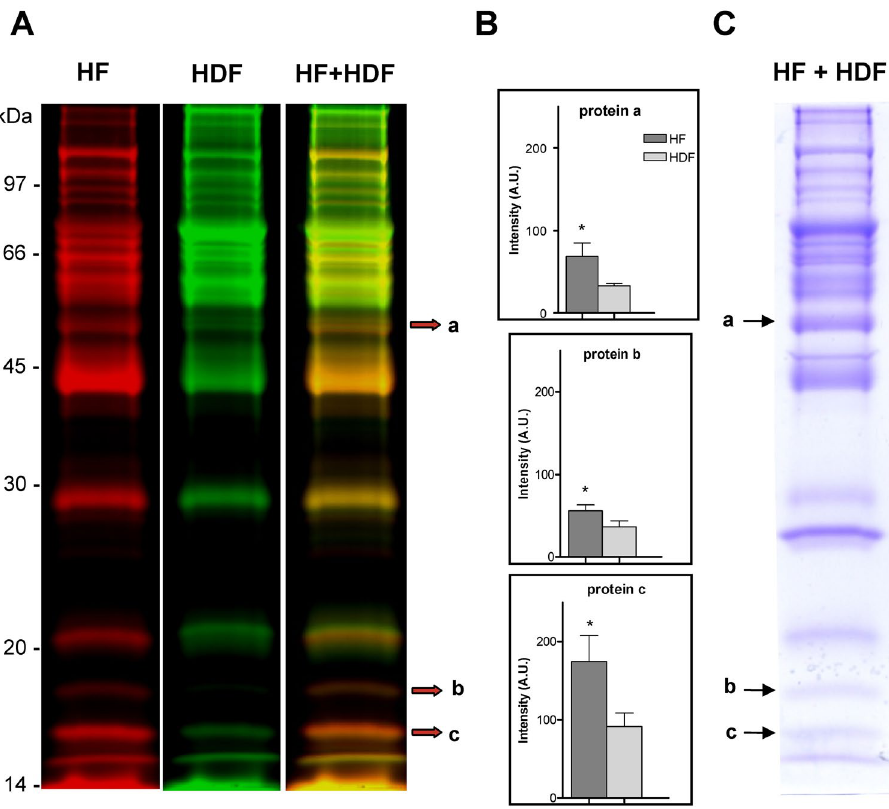
Figure 1. Differential protein detection of plasma samples of HF compared with HDF patients by fluorescence in gel electrophoresis (DIGE). ( A ) Albumin- and IgG-depleted plasma samples from high-flux haemodialysis (HF) and on-line haemodiafiltration (HDF) patients, were labelled with Cy5 or Cy3 fluorescent dyes. After labelling, the HF and HDF samples were combined and analysed by sodium dodecyl sulphate–polyacrylamide gel electrophoresis (SDS-PAGE) and the gel was scanned to display fluorescence-labelled proteins. For representative purpose a gel of pooled plasma samples of HF and HDF labelled with Cys is shown; proteins in the HF sample were labelled with Cy5 (red) and proteins in the HDF sample labelled with Cy3 (green). Proteins present in both HF and HDF samples were visualised in yellow due to the merge of the red and green labels (HF + HDF). The numbers on the left indicate the apparent molecular mass in kDa. The combinations of individual paired and Cy-labelled samples of HF and HDF are shown in Figure S2. ( B ) Quantification of the fluorescent proteins detected in individual HF and HDF samples from Figure S2 for differential detection. Graphs show the proteins levels (fluorescence intensity, in arbitrary units, A.U.) with significant differences in HF compared with HDF samples. Data represented as the mean of 9 independent combinations of 9 HF and 9 HDF patients. Error bars indicate SE; * p < 0.05, HF compared with HDF by t-test. The differentially detected proteins, a to c , are indicated in A by arrows with the highest labelling colour code (red, HF patients). ( C ) Gel A stained with Coomassie blue for protein staining and subsequent MALDI-TOF MS identification. Letters indicate the differentially detected proteins. Images of fluorescence labelling in A and stained image in C are a representative result and correspond to the same gel